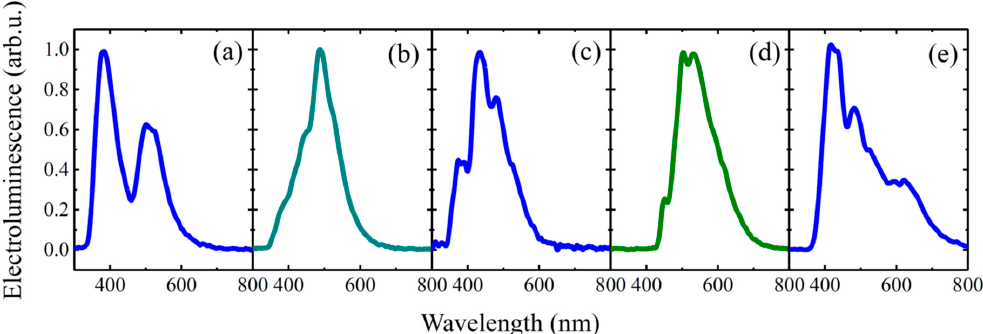
Figure 7. Normalized electroluminescence spectra of ( a ) 2a , ( b ) 2b , ( c ) 2c , ( d ) 2d , and ( e ) 2e